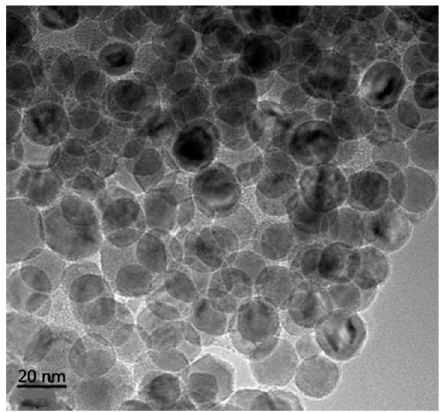
Figure 1. TEM of Fe 3 O 4 nanoparticles.